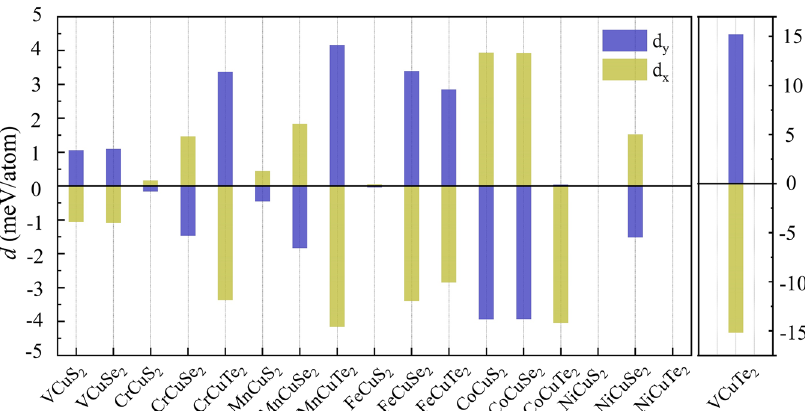
Fig. 2 The calculated anisotropic DMI of monolayer M Cu X 2 . Yellow and blue bars indicate the DMI components of NN magnetic atoms along x and y direction, respectively. Here, d > 0 ( d < 0) represents the anticlockwise (clockwise) chirality.